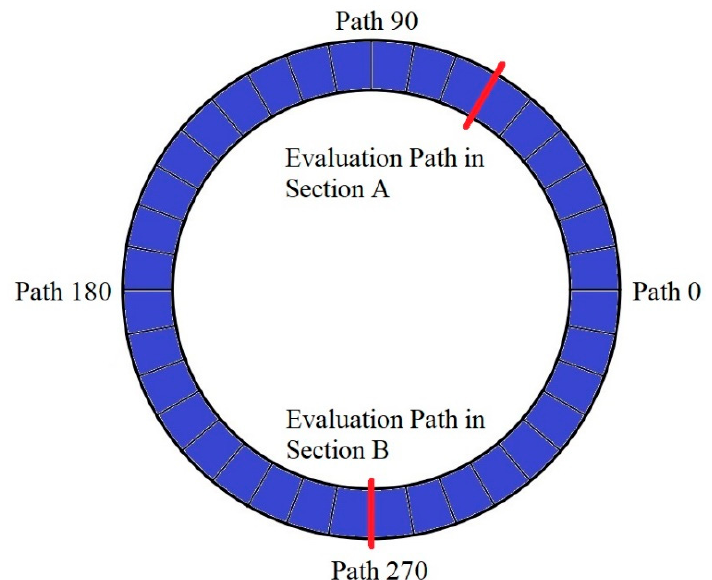
Figure 10. The paths in the monitoring sections.